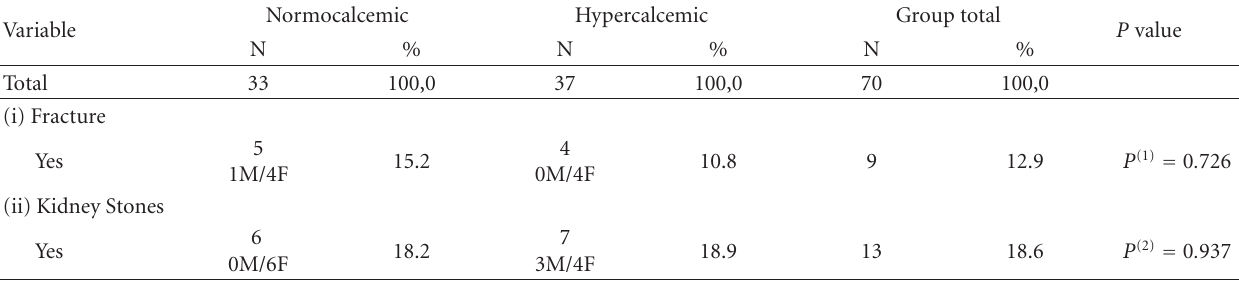
Table 2: History of fracture and kidney stones in normocalcemic and hypercalcemic PHPT.